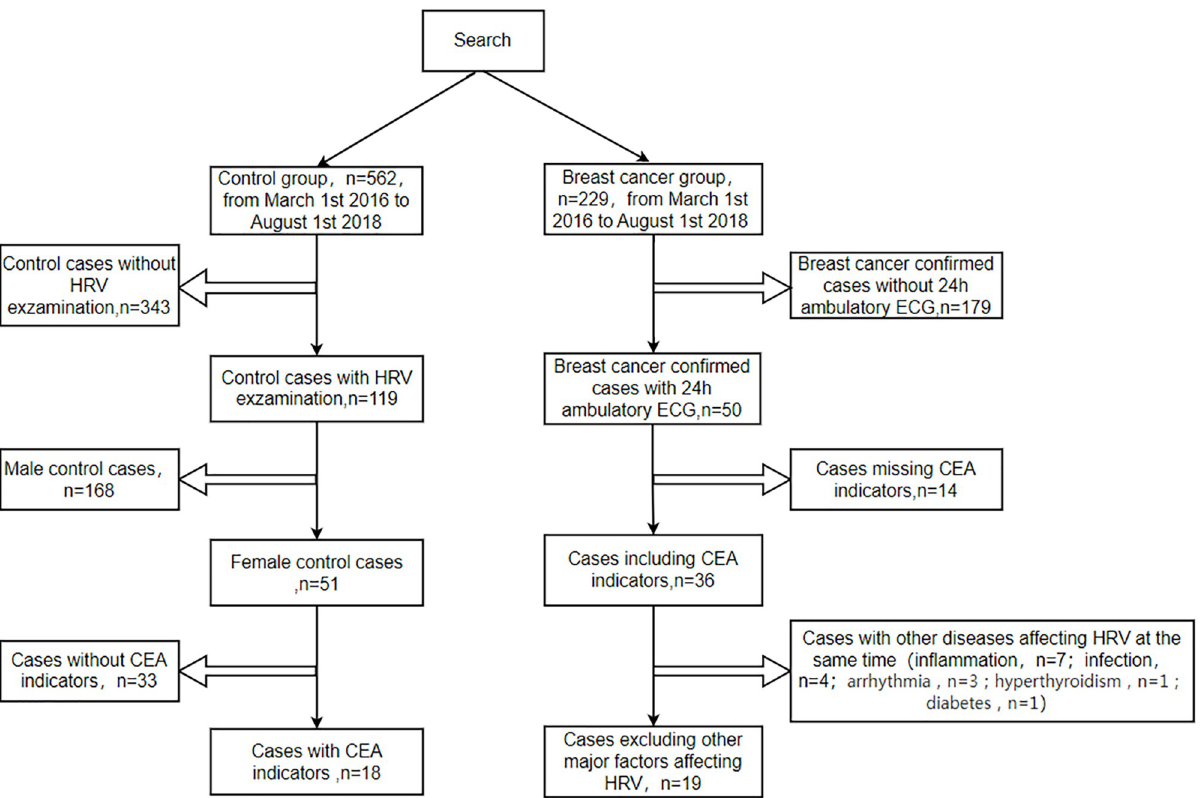
Fig 1. Inclusion and exclusion criteria for patient selection. HRV, heart rate variability; CEA, carcinoembryonic antigen; ECG, electrocardiogram.